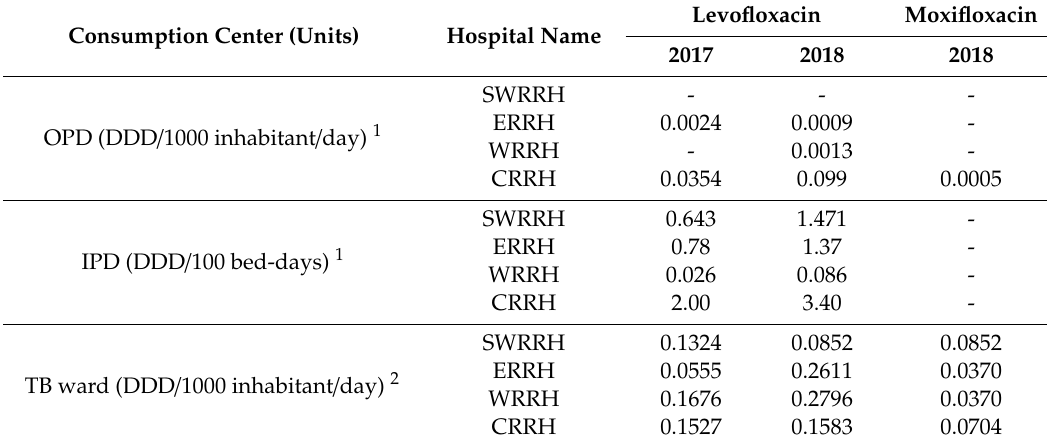
Table 1. Evolution of the consumption of levofloxacin and moxifloxacin in the di ff erent wards of the studied hospitals in 2017 and